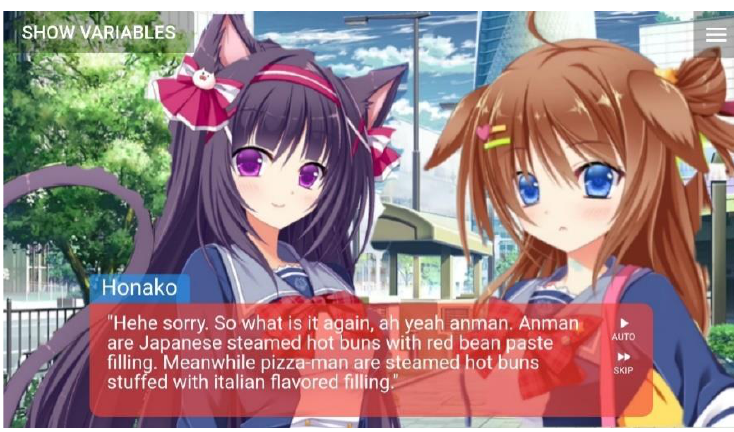
Picture 4. Story in the